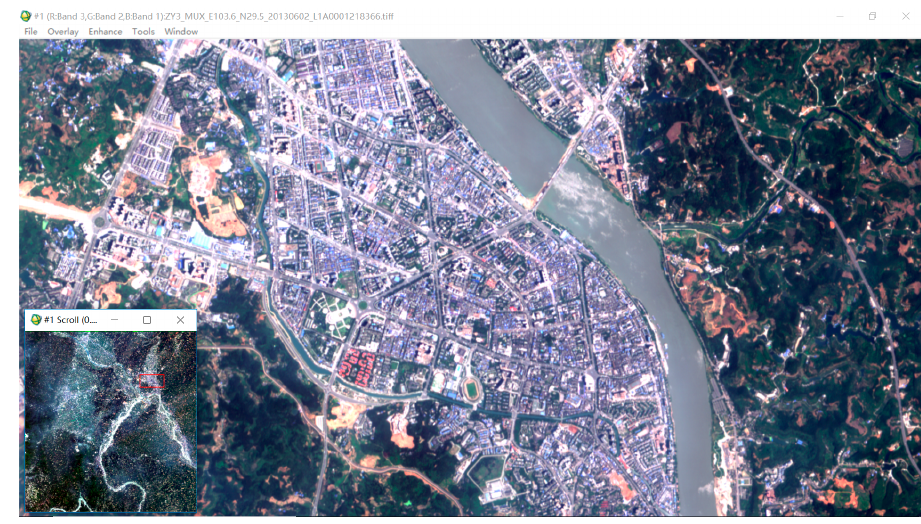
Figure 4. True color image of LS taken in June 2018 with a multi-spectral sensor mounted on the ZY03 satellite.